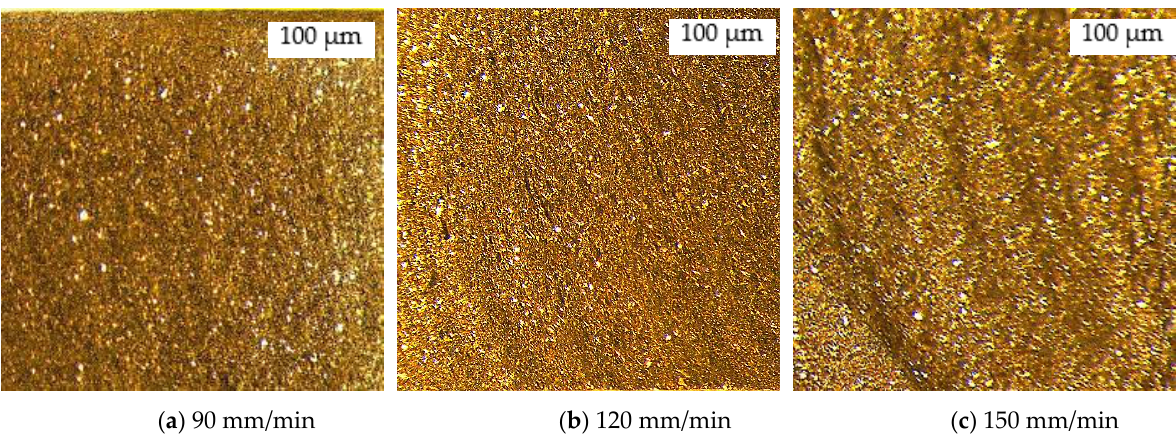
Figure 5. Topography of AISI 304L cut surface with 8 mm thickness using varied traverse speed.